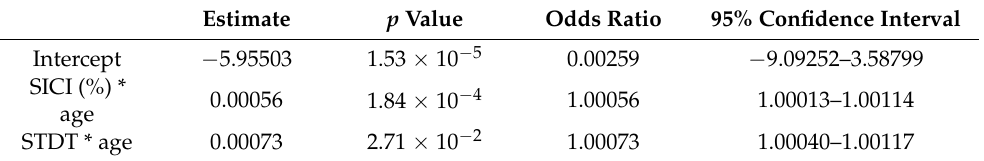
Table 4. Logistic regression model. Dependent variable: multiple sclerosis subtype (RRMS vs. SPMS).